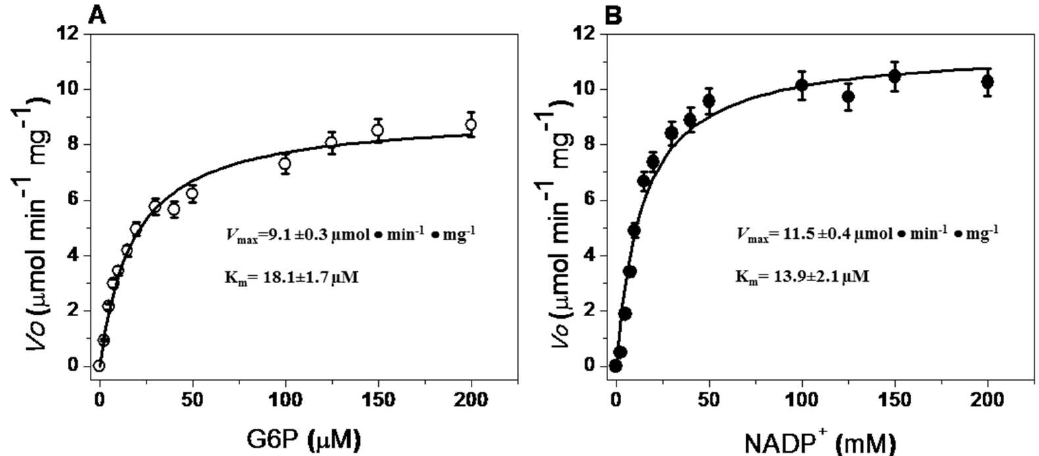
Figure 6. Representative kinetic plots of G6PD::6PGL with ( A ) G6P and ( B ) NADP + as substrates. Initial velocity data obtained from initial-rate measurements varying one substrate concentration indicated in the abscissa axis with the second substrate fixed at saturating concentration. The data represent mean ± SD from three independent